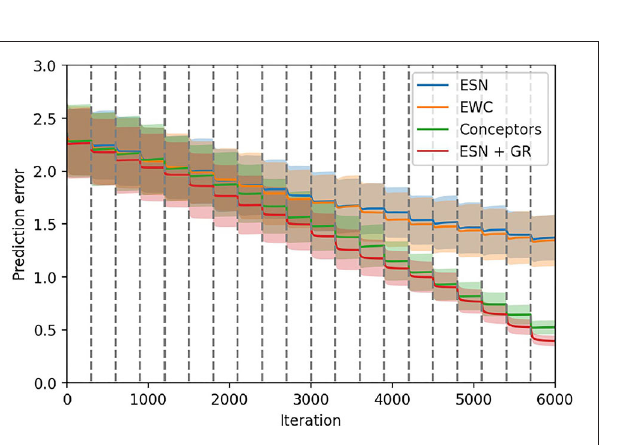
FIGURE 7 | Comparison between the four learning methods for the output weights on the first test set. The 20 tasks are delimited by the dashed gray lines.